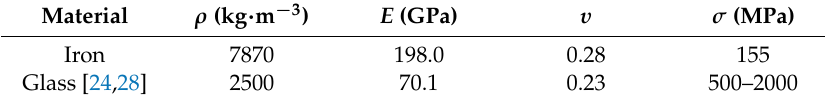
Table 1. Material properties used for numerical analysis.